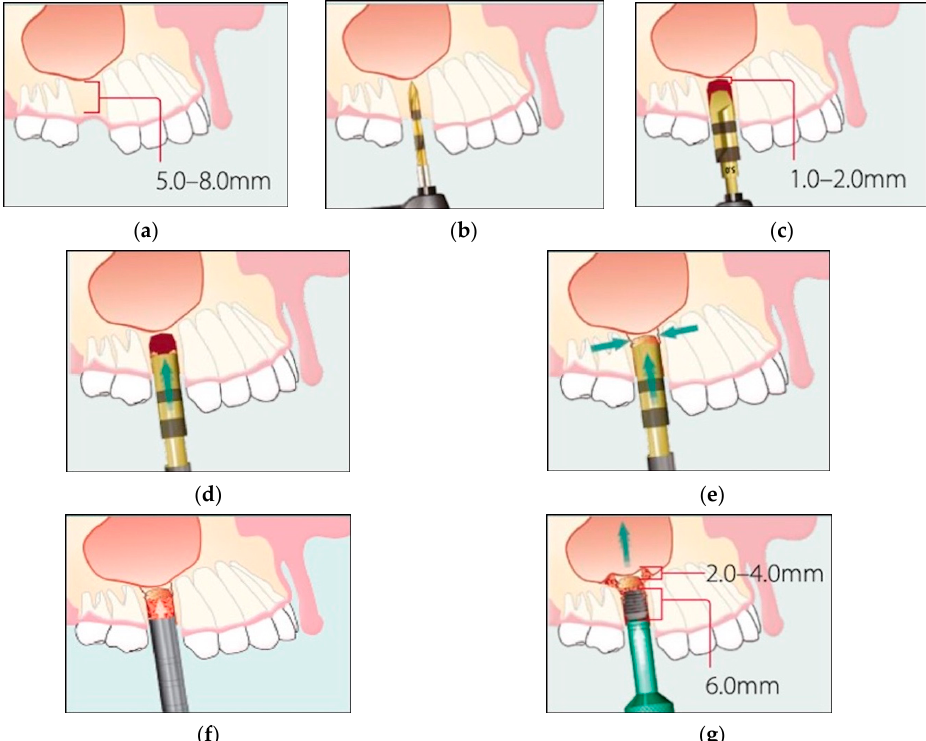
Figure 1 . ( a – g ). Schematic drawing of internal sinus lift (ISL) technique with Bicon dental implant. ( a